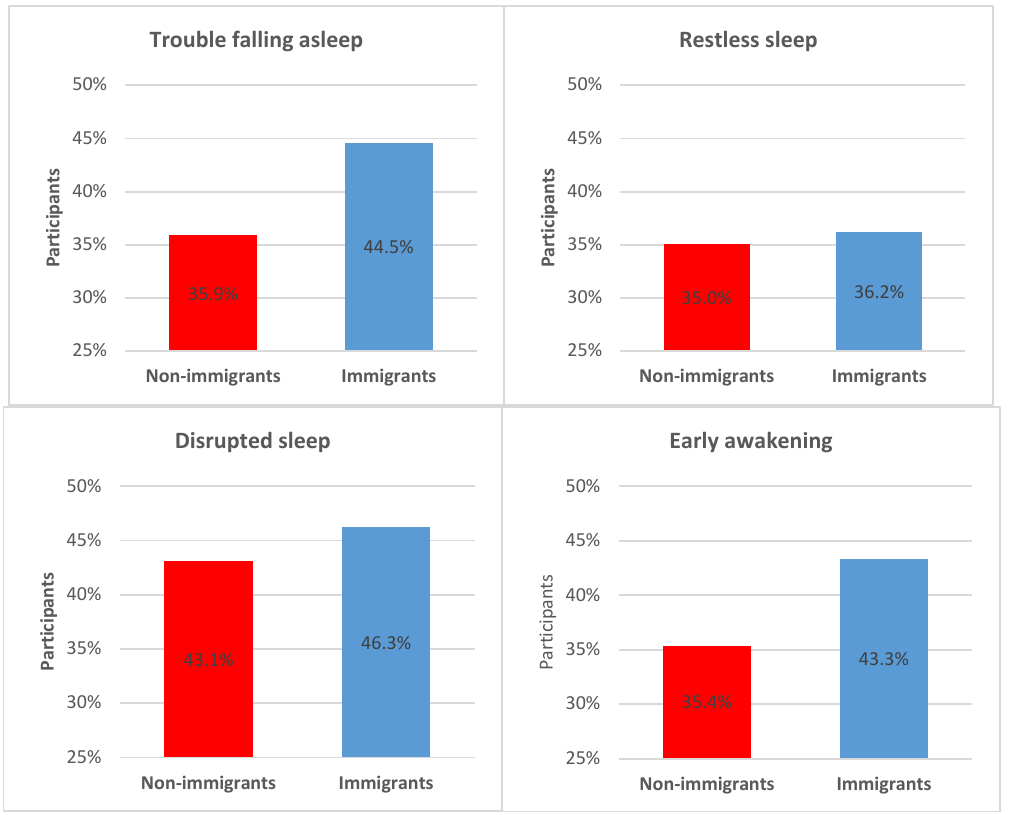
Figure 1. Sleep disorder symptoms stratified by migration status. Total population N = 17,968, non-immigrant population n = 14,562, immigrant population n = 3406. Multiple answers possible: trouble falling asleep, p < 0.001; restless sleep, p = 0.194; disrupted sleep, p = 0.001; early awakening, p < 0.001.